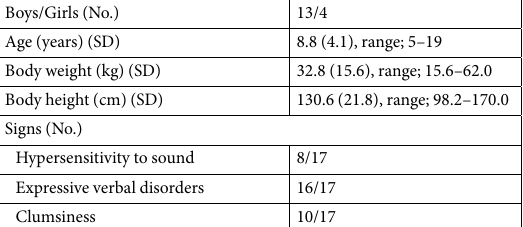
Table 1. Characteristics and selected signs of participants before intervention. No., number. SD, standard